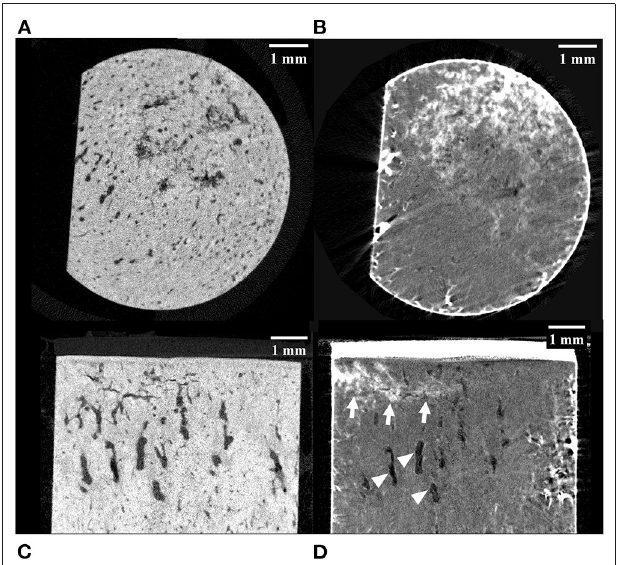
FIGURE 3 | MicroCT images of a palmar MCIII cartilage-bone specimen from a Thoroughbred racehorse. (A,C) are unlabelled images without evidence of microfractures, while (B,D) are labeled images taken at approximately equivalent slices after staining the bone with lead-uranyl acetate showing small areas of label uptake near the articular surface consistent with microdamage (highlighted by white arrows). Image (A,B) are short axis images taken approximately 0.5mm below the mineralized to non-mineralized cartilage interface. Images (C,D) are long axis images of the superficial half of the specimen. Resorptive lesions are present (arrowheads).